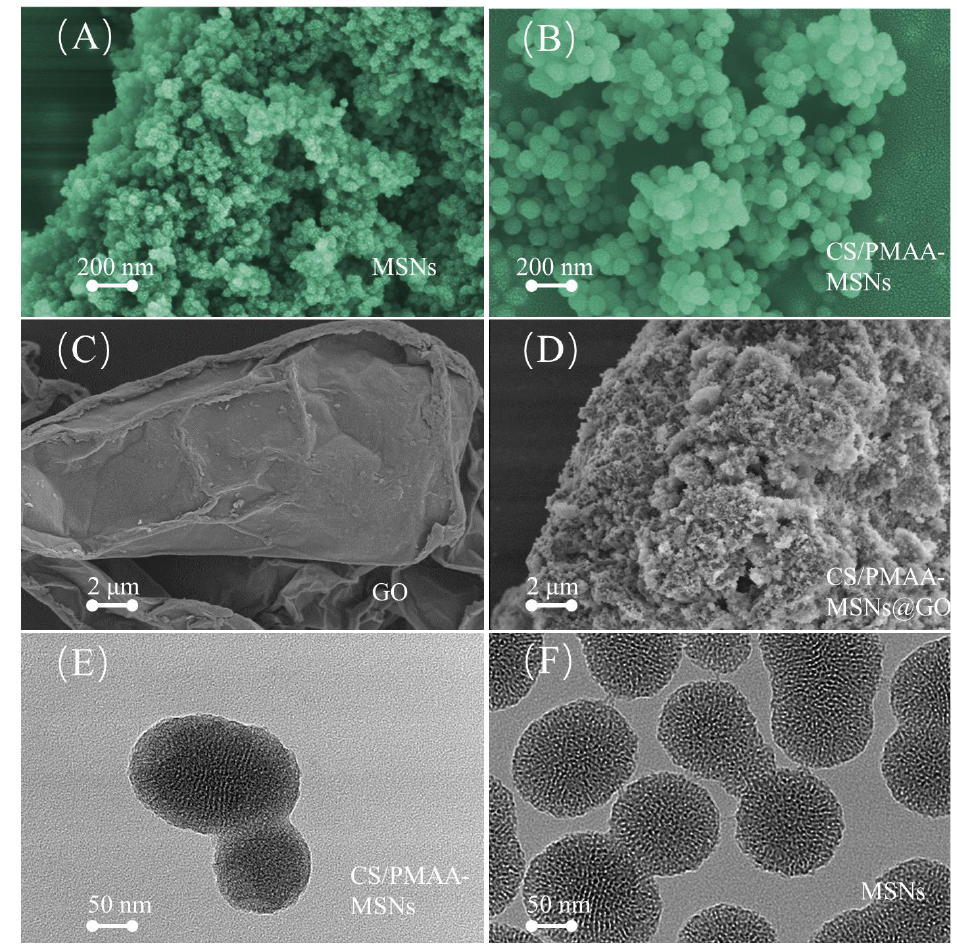
Figure 5. ( A ) SEM images of MSNs, ( B ) CS/PMAA-MSNs, ( D ) GO, and ( E ) CS/PMAA-MSNs@GO; TEM images of ( C ) MSNs and ( F ) CS/PMAA-MSNs.